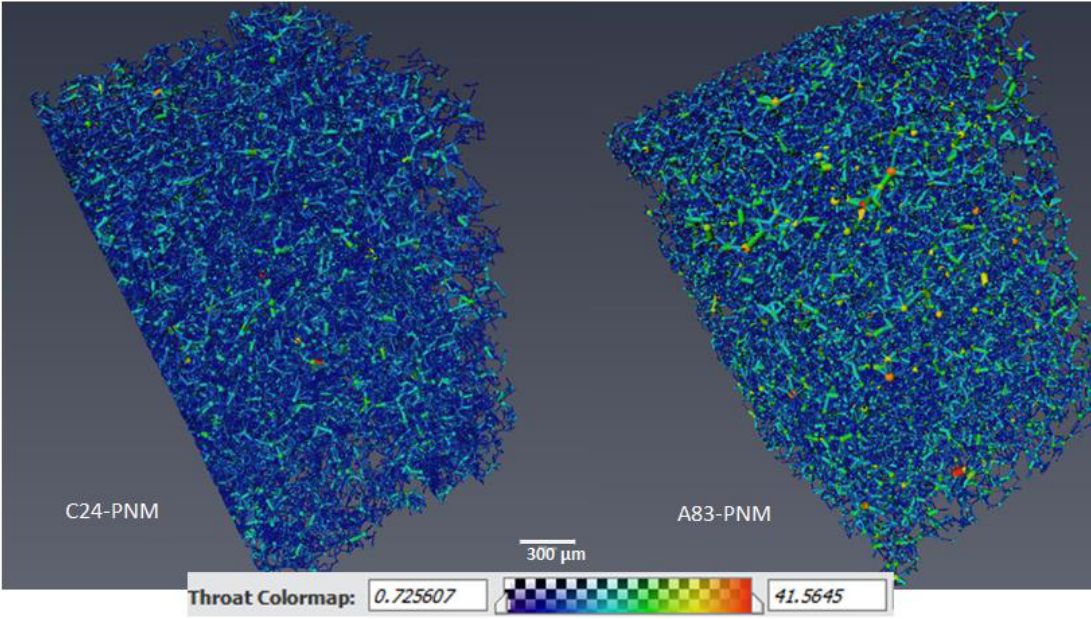
Figure 22. Pore throat size distribution in the range of 1 – 50 µm. On the y-axis is the count (frequency) and the x-axis is the corresponding equivalent radii (EqRadius in µm) of the pore throats.